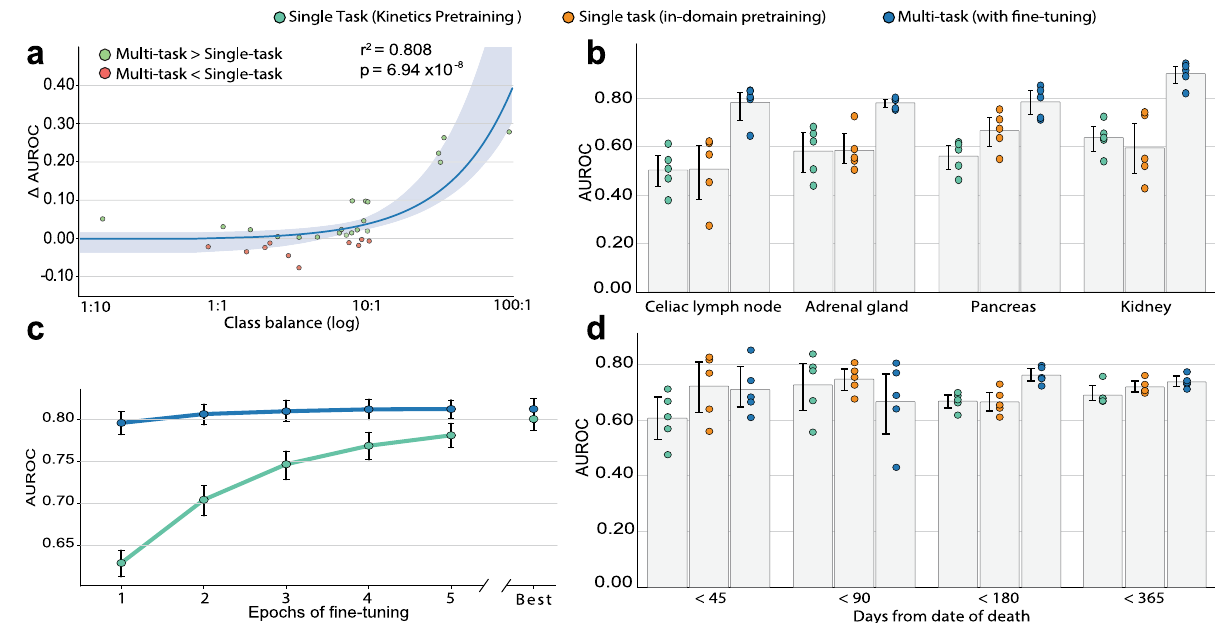
Fig. 4 Multi-task learning improves automated location estimation performance, reduces the computational cost, and facilitates mortality prediction. a Gains from multi-task learning are the greatest in regions with severe class imbalance. For each region, the difference in abnormality detection AUROC between a multi-task model and a single-task model is plotted against the class balance for the region. If a region exhibits class balance 10:1, then for every exam with an abnormality in the region, there will be ten exams where the region is normal. The single-task and multi-task models were both trained on fi ve different random seeds and differences in mean AUROC are plotted. We also fi t a linear model to the two variables and report Pearson correlation coef fi cient r 2 = 0.808 and two-sided p -value = 6.94 × 10 − 8 computed using the Wald test. Shaded regions represent 95% con fi dence intervals computed via bootstrapping across n = 30 regions (e.g., pancreas, lungs). b Multi-task learning improves performance in regions in which